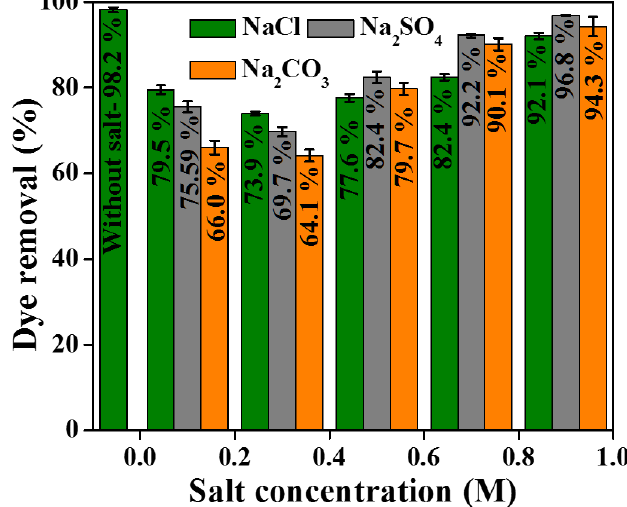
Figure 11. Effect of salt concentration on adsorption of CR onto DE-LDH (dye concentration: 50 mg/L, dosage: 40 mg, pH: 7 and time: 1 h).